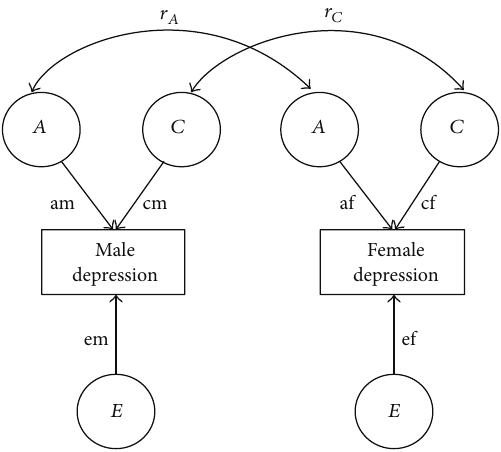
Figure 1: Sex-limitation model for adolescent depressive symptoms. The magnitude of additive genetic ( 𝐴 ), shared environmental ( 𝐶 ), and nonshared environmental ( 𝐸 ) influences may differ for males and females (am ̸= af, cm ̸= cf, and em ̸= ef), and/or the genetic ( 𝑟 𝐴 ) or shared environmental ( 𝑟 𝐶 ) correlation among opposite-sex twins may fall below the expected genetic (.50) and shared environmental (1.00) correlations for same-sex dizygotic